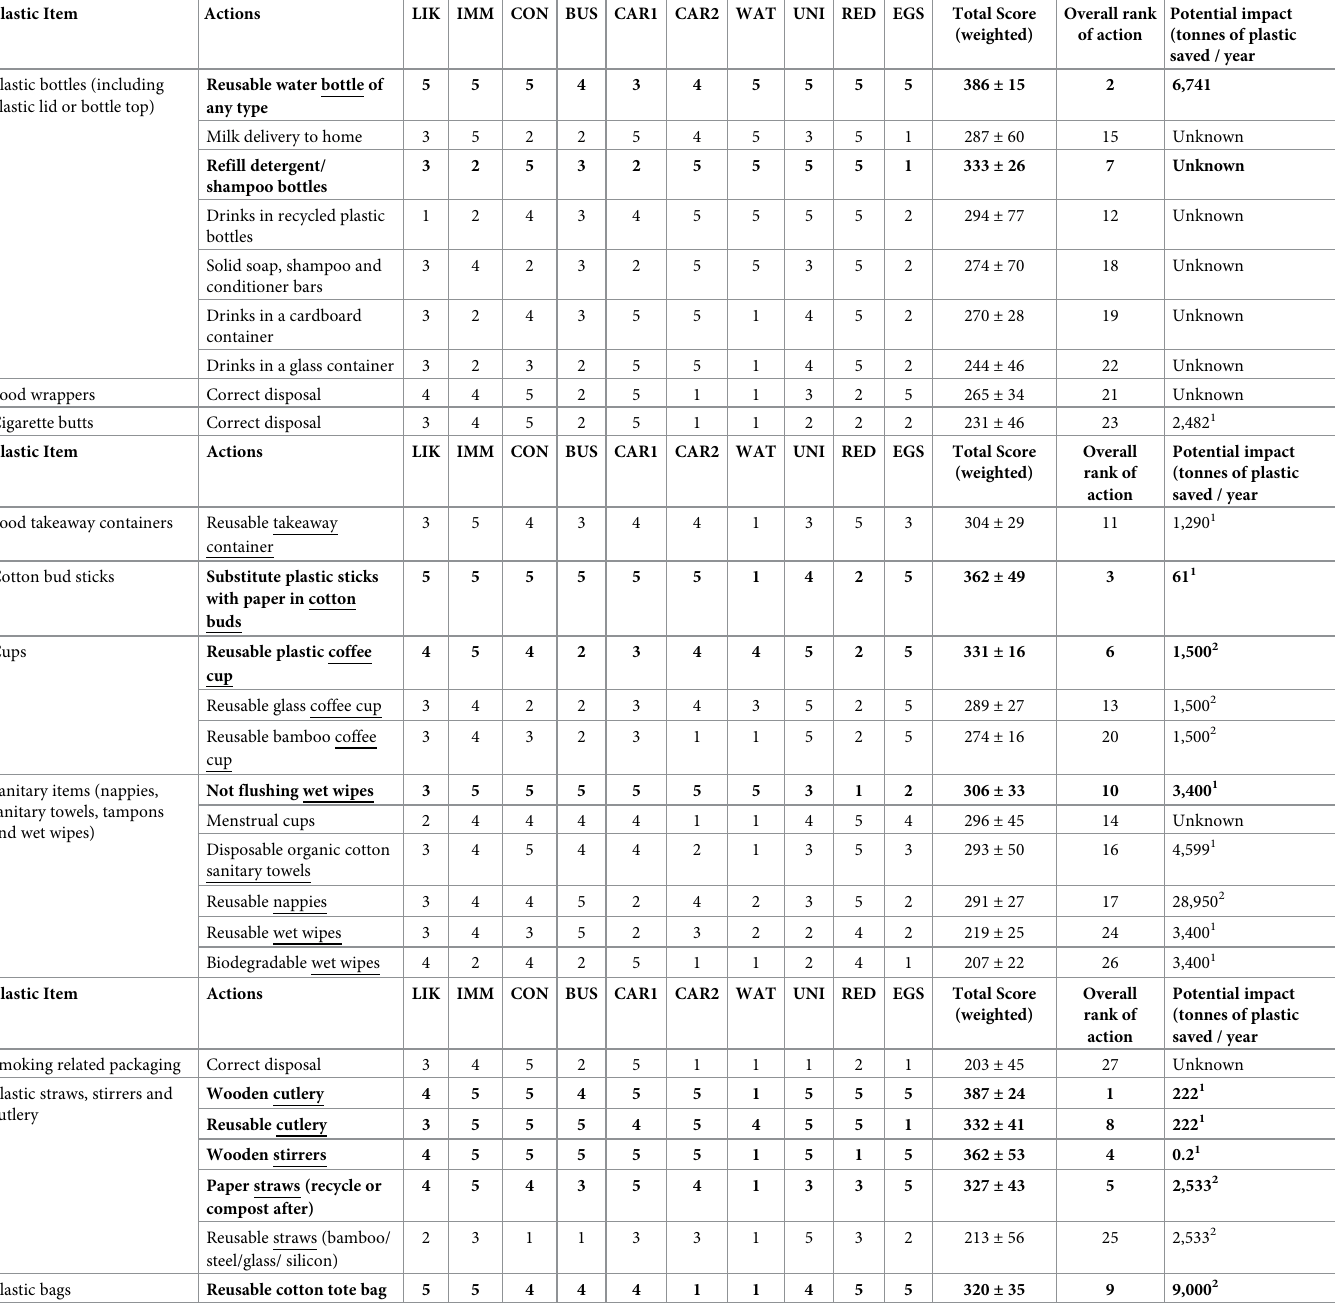
Table 2. Quantified effectiveness of consumer actions (total, weighted MCDA scores) to reduce plastic pollution related to the top ten most prevalent consumer macroplastic items in European freshwater environments [10] Plastic Item